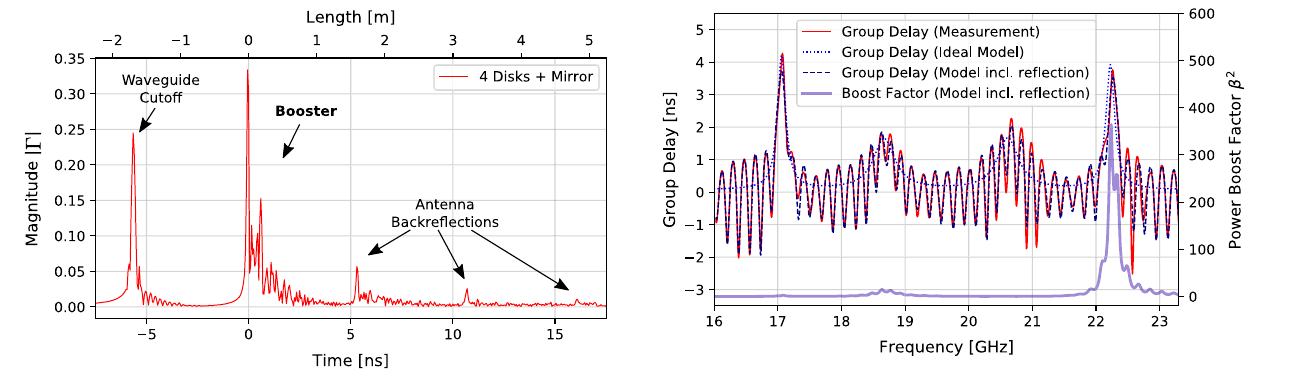
Fig. 6 Measured reflectivities in time domain for a setup with the cop- per mirror and 4 sapphire disks. The corresponding length assumes free space propagation